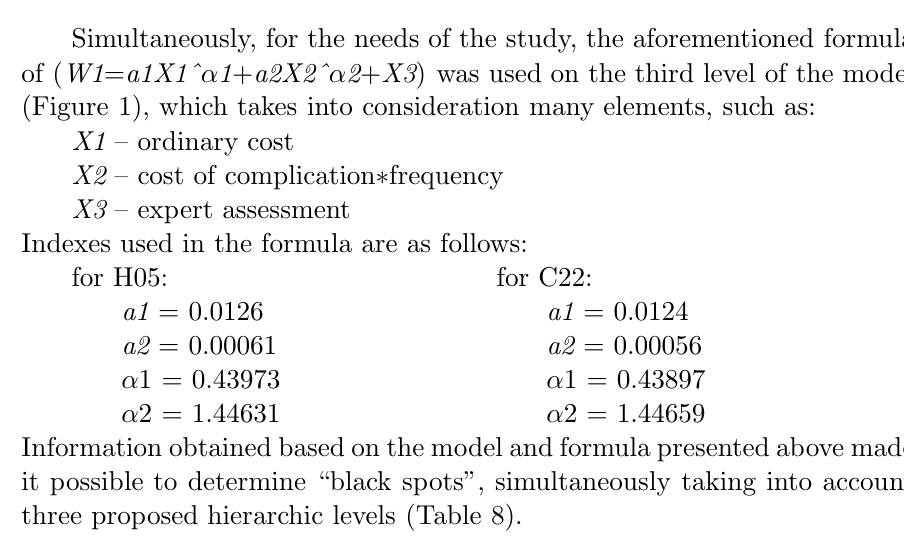
Table 8. List of ‘black spots’ on various hierarchic levels Hospitalization Black